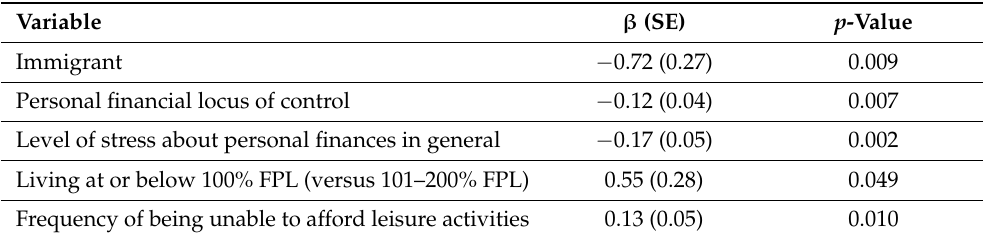
Table 2. Significant associations between participant characteristics and delay discounting at